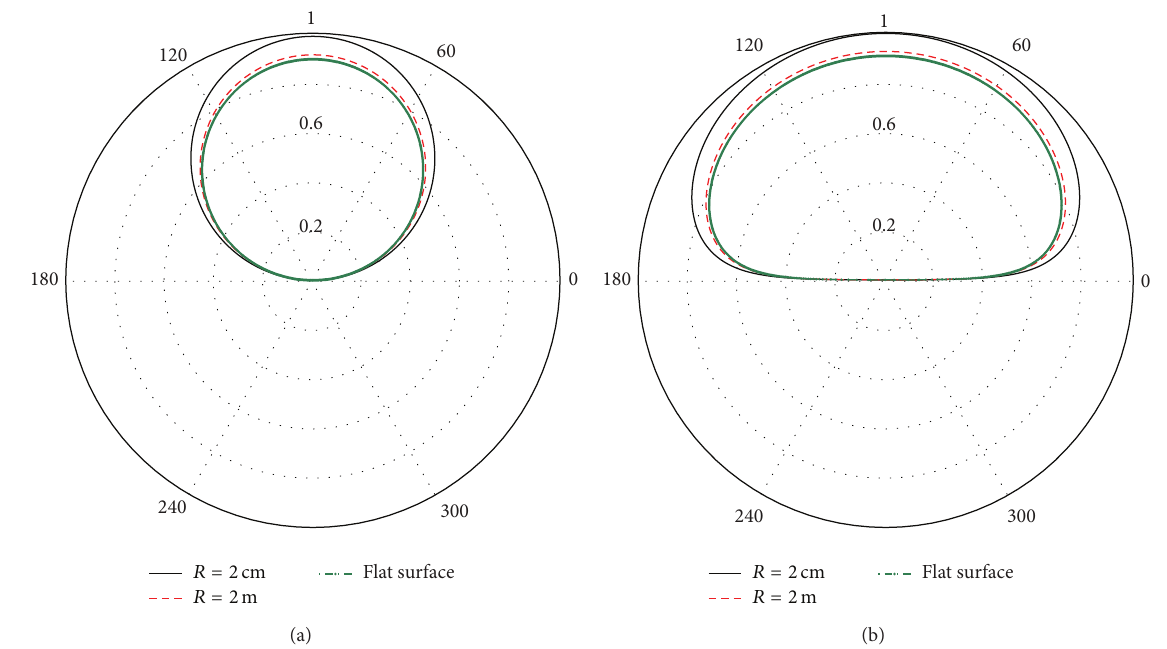
Figure 4: (a) Normalized 𝐻 -plane ( 𝜑 = 90 ∘ , 270 ∘ ) and (b) normalized 𝐸 -plane ( 𝜑 = 0 ∘ , 180 ∘ ) in dB at radii of curvature 2 cm, 2m and flat surface. “Teflon substrate.”